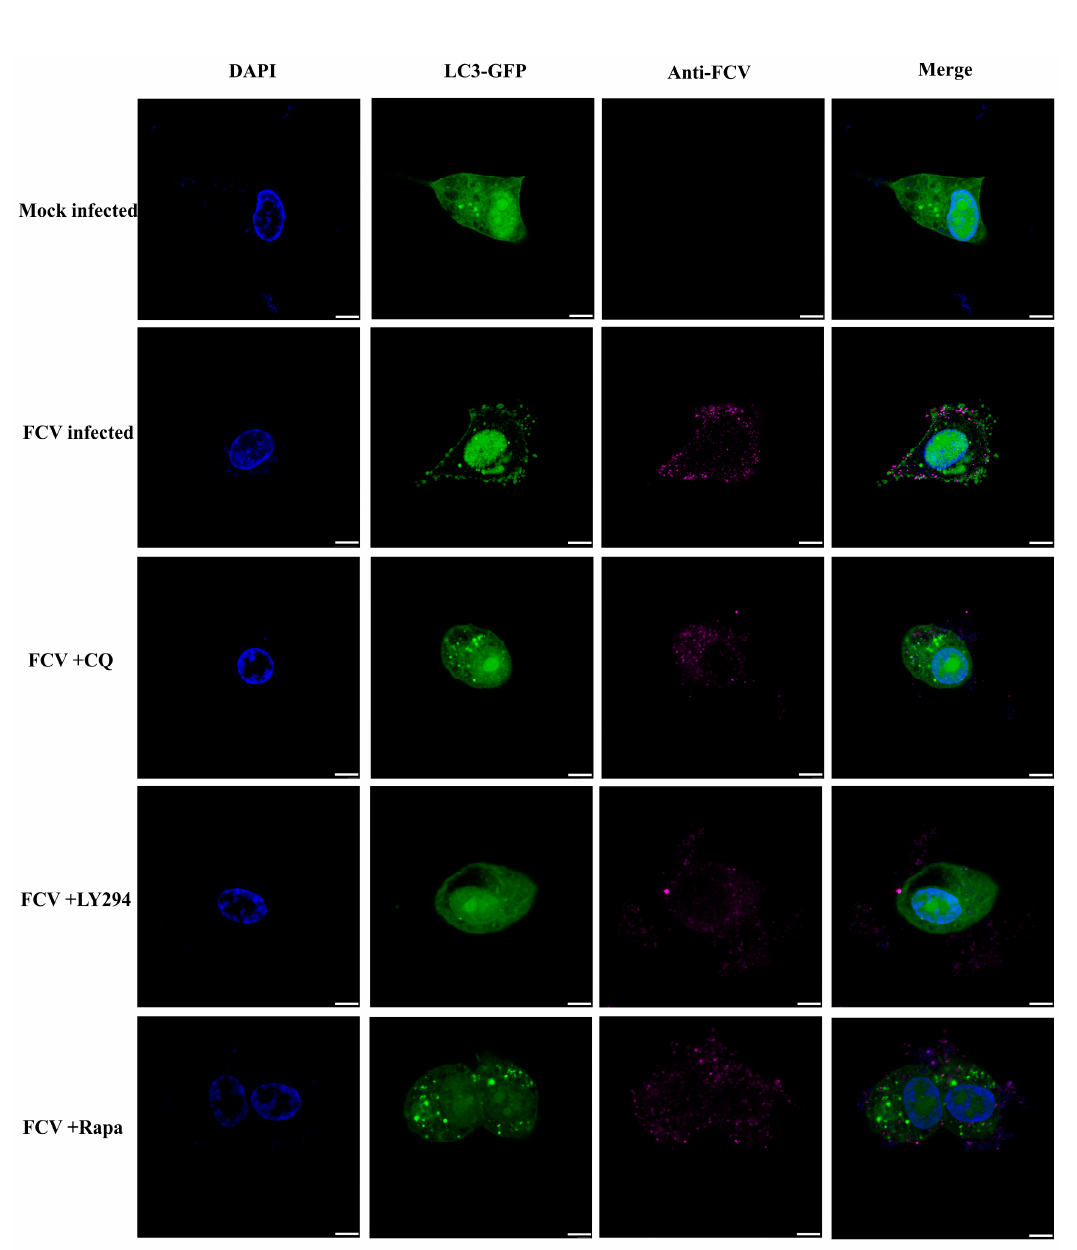
Figure 4. CRFK cells were transfected with GFP-LC3 (green), and 24 h later, infected with FCV at an MOI of 1, fixed at 12 h.p.i., and labeled with FCV antibody (purple). Scale bar 5 µm.